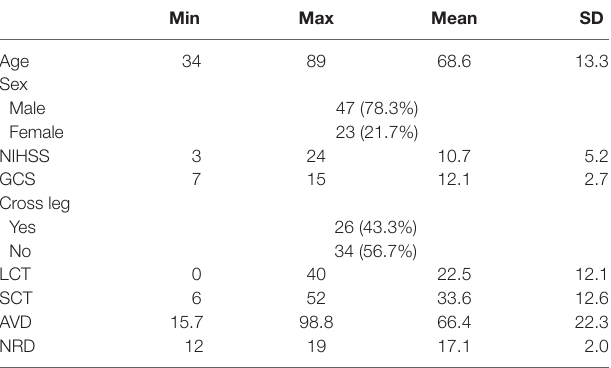
TaBle 1 | Demographic and clinical characteristics of the